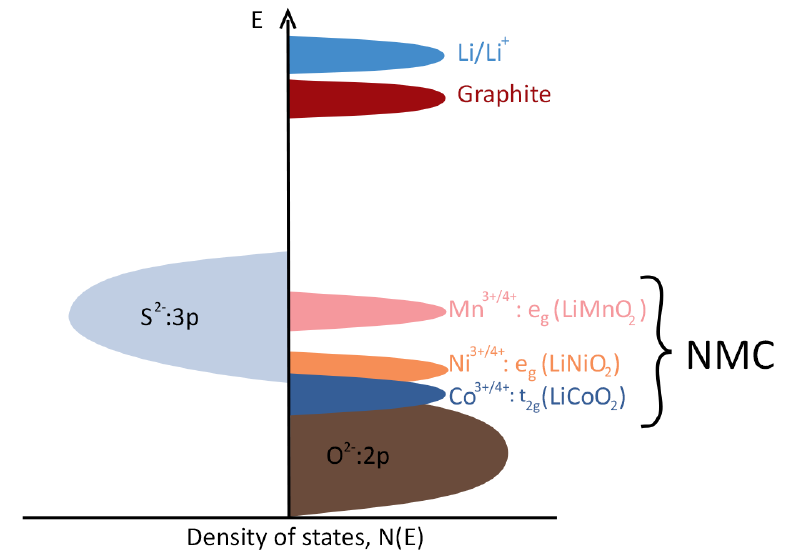
Figure 6. Schematic representation of the density of states of Li 2 S, graphite, LiMnO 2 , LiNiO 2 , LiCoO 2 , and NMC. Adapted from